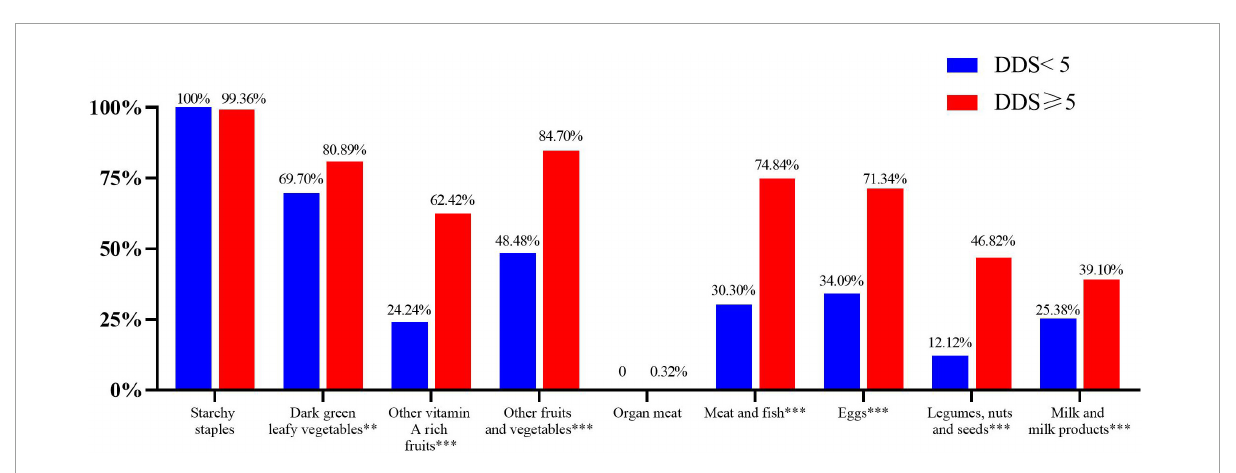
FIGURE1 Percentage of participants consuming each food group.